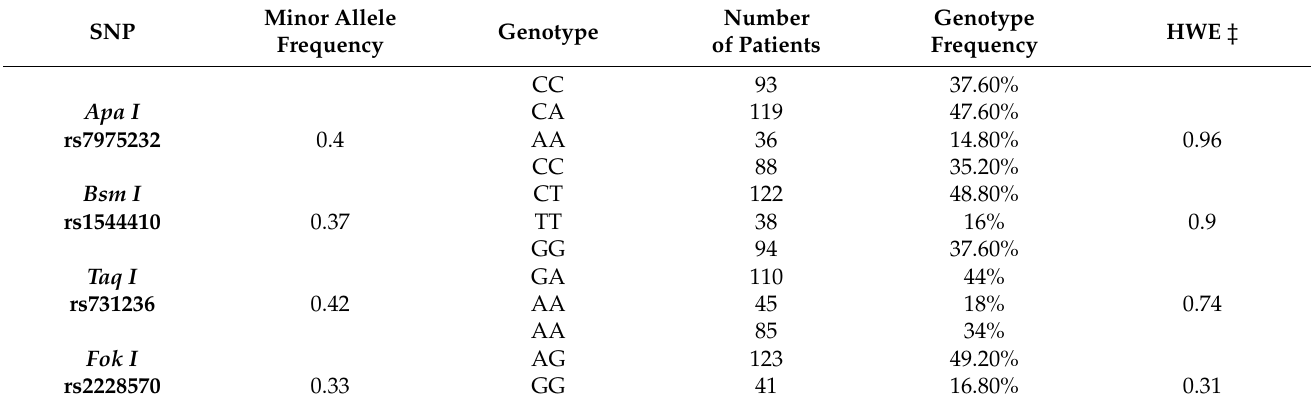
Table 3. Distribution of the examined genetic polymorphisms in the study population.